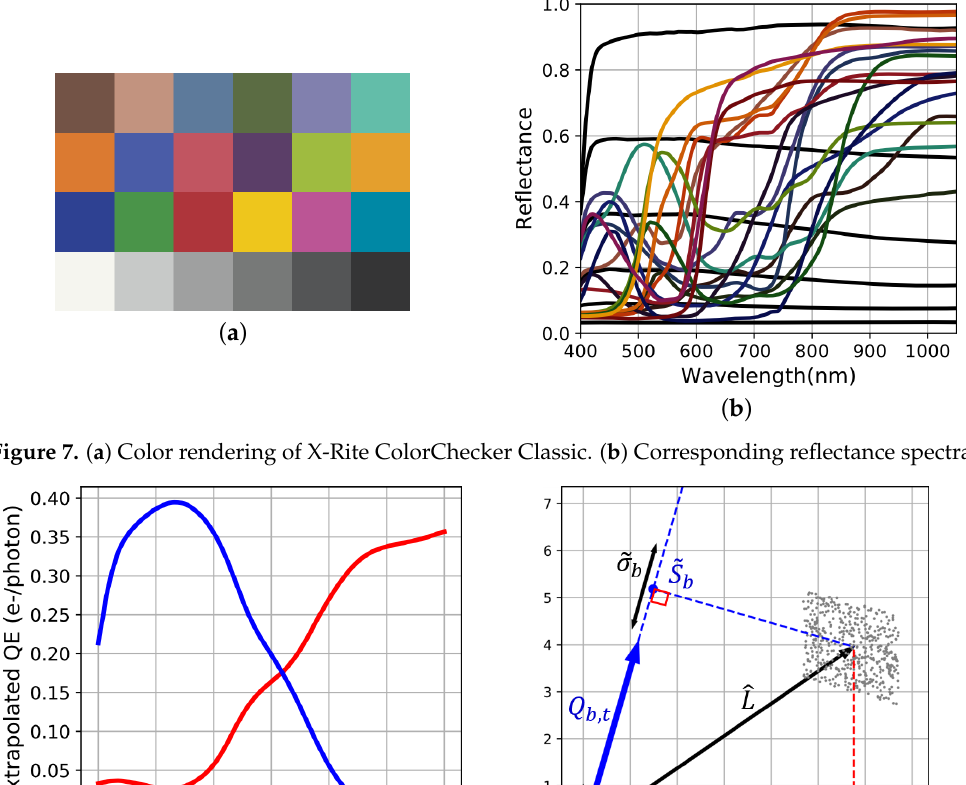
(cid:13) (cid:13) and instead of (cid:107) Q r (cid:107) and (cid:13) Q b , t (cid:13) 2 2 2